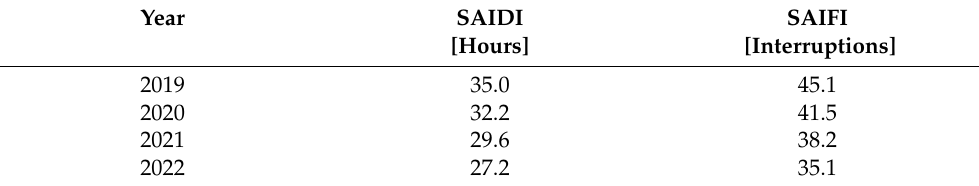
Table 6. Limits for SAIDI and SAIFI in Colombia.